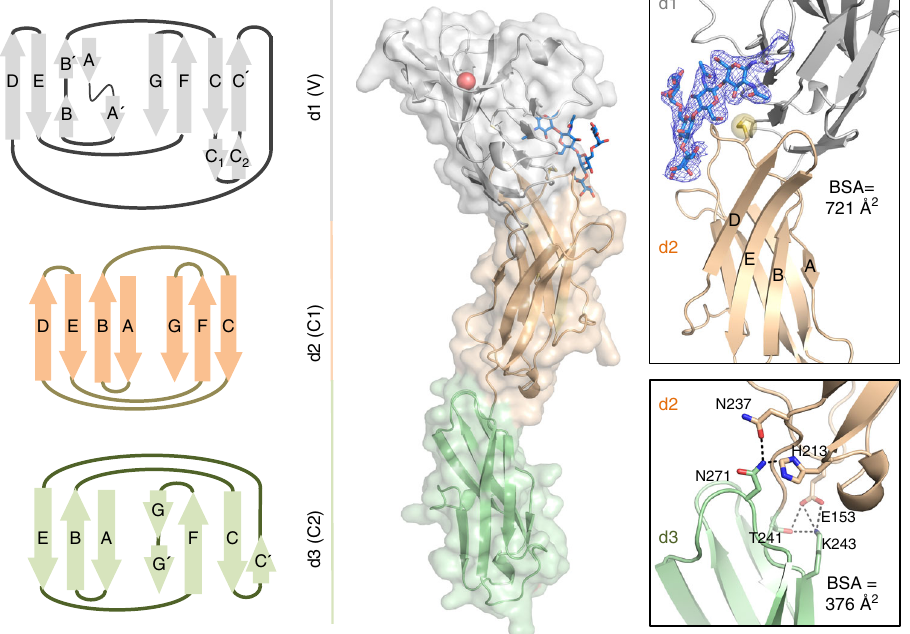
Fig. 1 Three-dimensional structure of human CD22. Crystal structure of the three N-terminal Ig domains of human CD22 (d1 – d3) represented as a schematic diagram, secondary structure cartoon, and transparent surface. d1 ( gray ) adopts a V-type Ig domain fold and R120 known to bind Sia is depicted as a red sphere . d2 ( wheat ) adopts an unexpected C1-type Ig domain fold, while d3 ( green ) is of C2-type fold. Insets show inter-domain interfaces of d1/d2 ( top ) and d2/d3 ( bottom ). CD22 d2 strands D – E are unusually elongated and contribute to the extensive d1 – d2 interface. A blue mesh represents the composite omit electron density map (1.0 σ contour level) associated with the N101 glycan ( sticks ) involved in shaping the d1/d2 interface. Inter-domain disulphide bond C39-C167, highly conserved among Siglec family members, is shown as a yellow